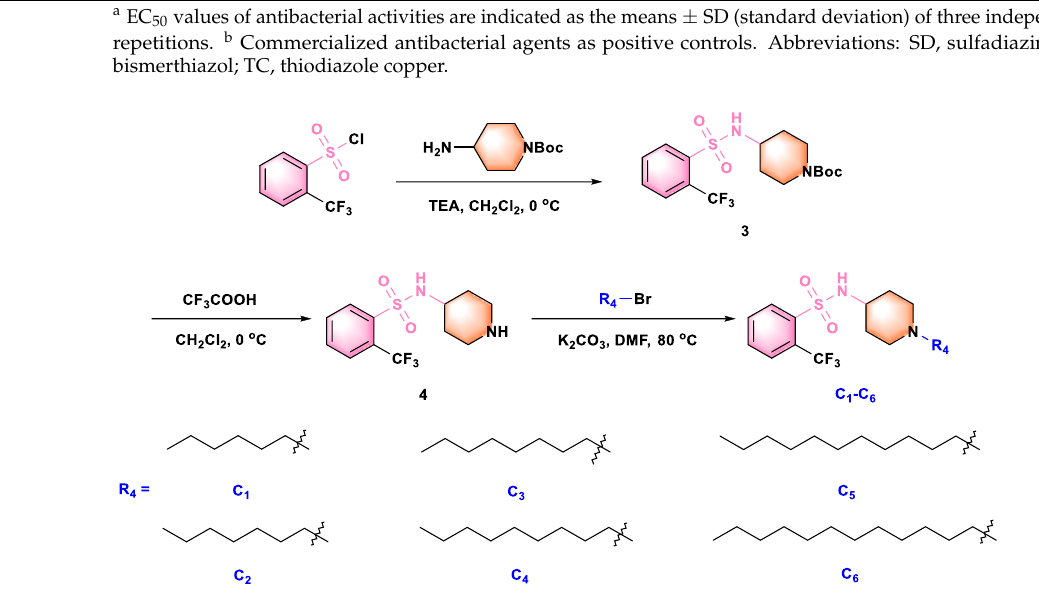
Scheme 3. Synthesis route of title molecules C 1 − C 6 Table 3. In vitro antibacterial activities of target molecules C 1 − C 6 against plant pathogens.